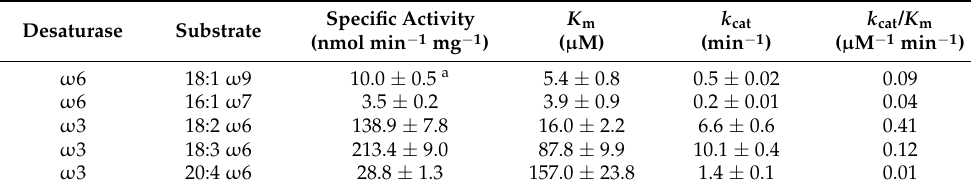
Figure 4. Kinetic analysis of NADPH-dependent ω 3 and ω 6 desaturation. ( a ) Michaelis–Menten analysis of the reaction between ω 3 desaturase and 18:2-CoA. ( b ) Michaelis–Menten analysis of the reaction between ω 6 desaturase and 18:1-CoA. See Table 1 for kinetic values determined for these substrates and others. Table 1. Kinetic parameters for M. alpina ω 6 and ω 3 desaturases with different fatty acid-CoA substrates in NADPH-dependent